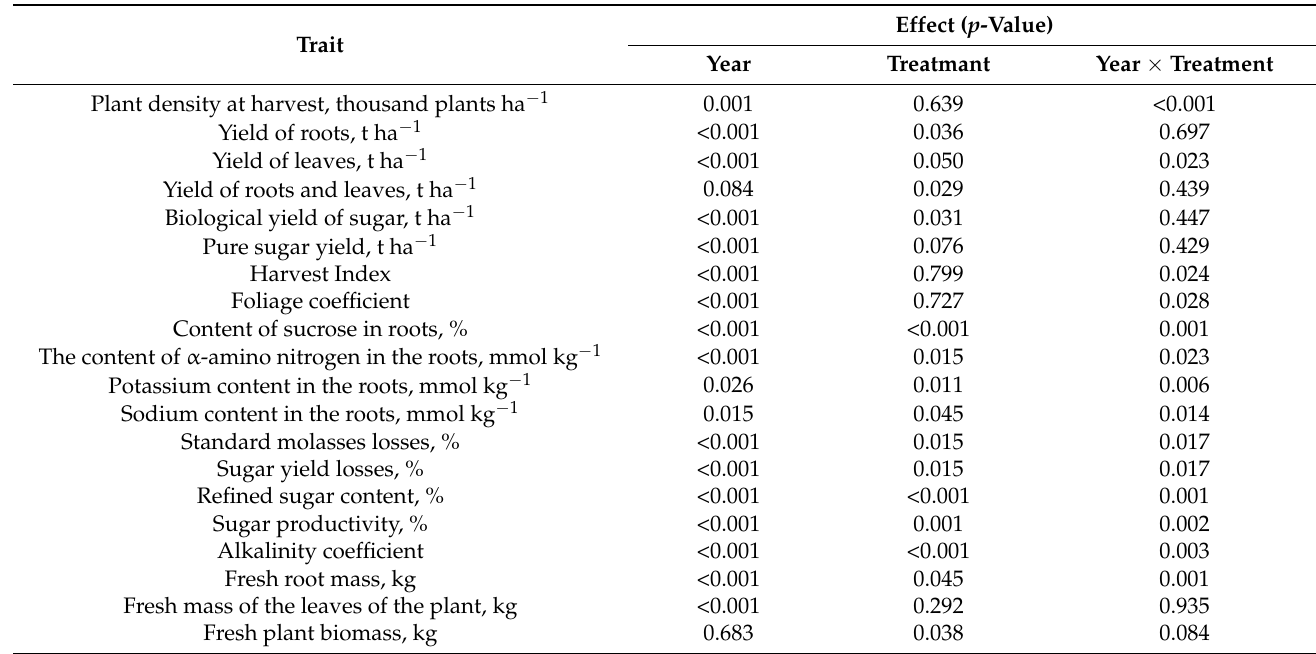
Table 3. Results based on analysis of variance (ANOVA) presenting effects ( p -values) of the factors and their interaction on the yield, the technological quality of the roots and traits of sugar beet plants (2017–2019).